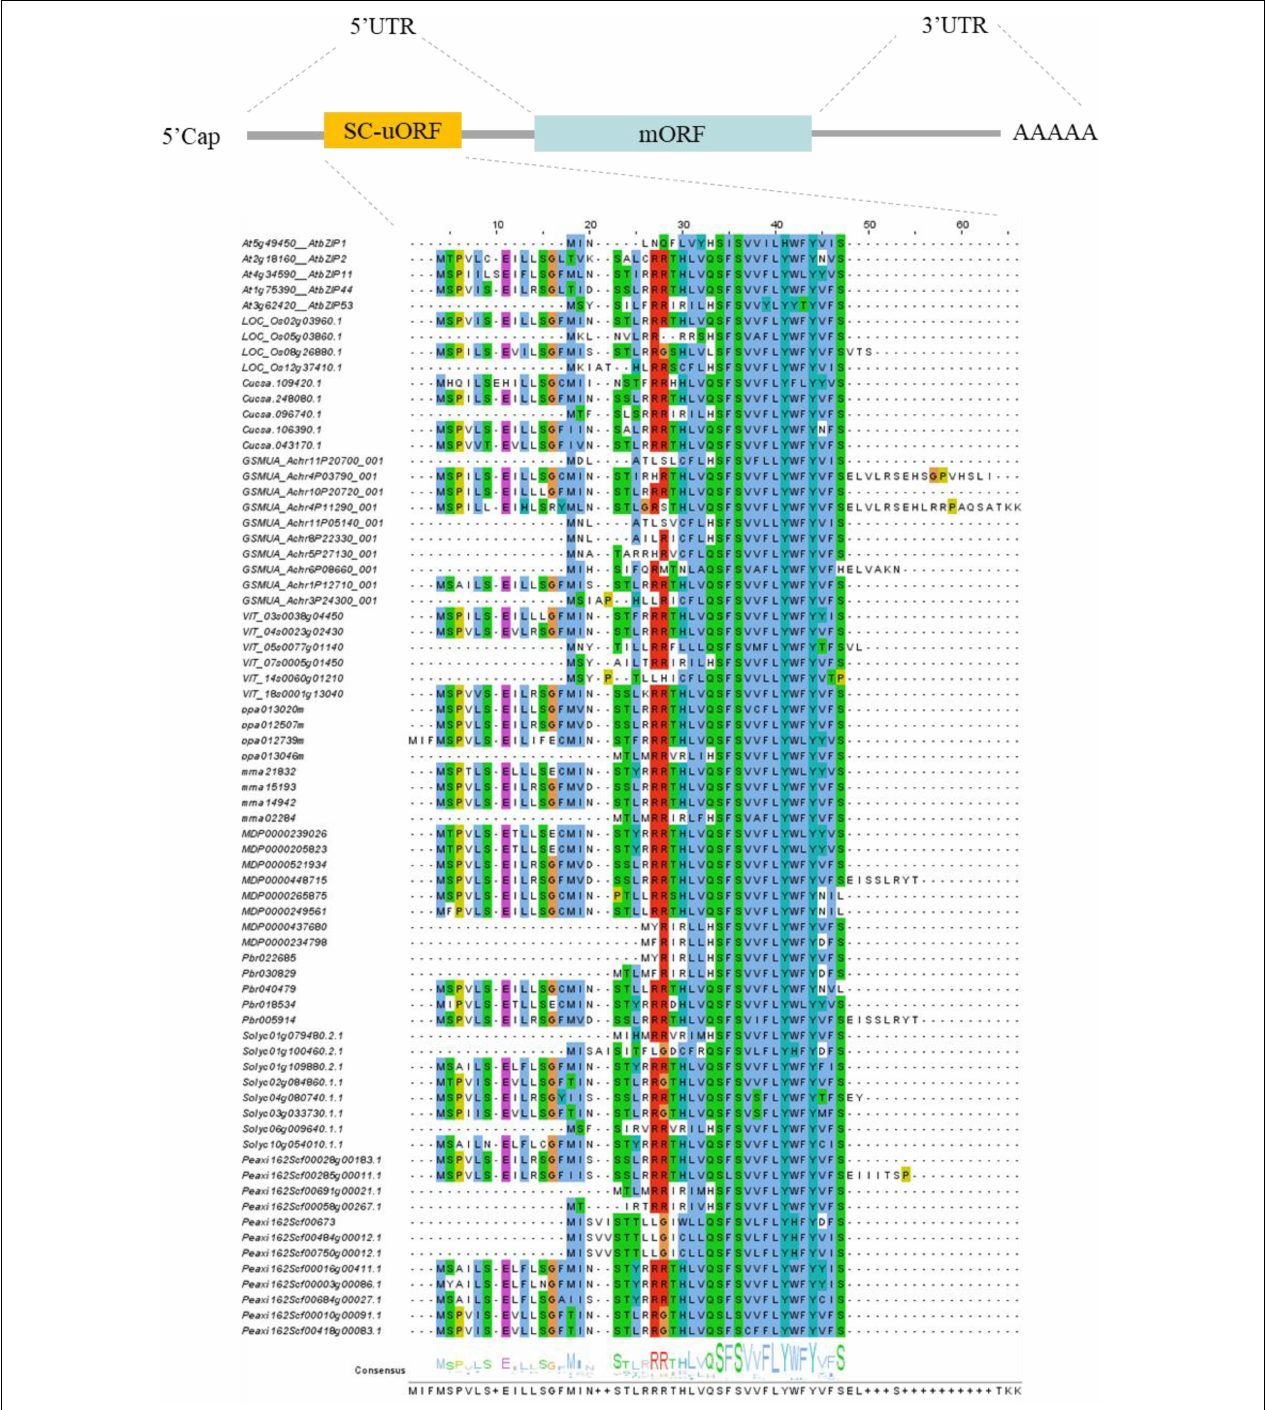
FIGURE 2 | Full-length gene structure of the S1-bZIPs, and alignment of the highly conserved S1-bZIP uORFs encoding the sucrose control peptide (SC-peptide) from some species. Conserved amino acids are depicted in color.